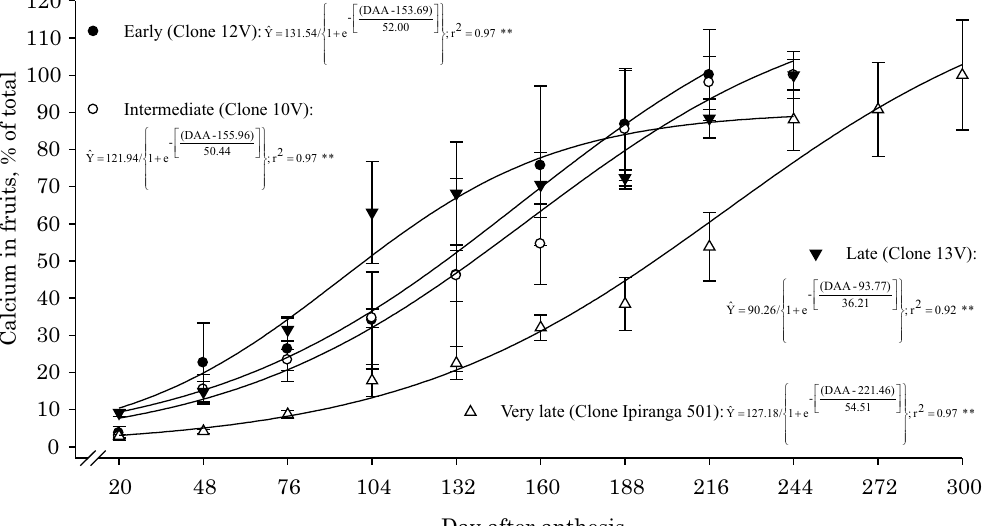
Figure 5. Accumulation of calcium in fruits (in percentage of the cumulative total) of four genotypes (clones) of Conilon coffee, from anthesis to fruit maturation. The bars refer to the standard error of the average. ** significant at 1 %